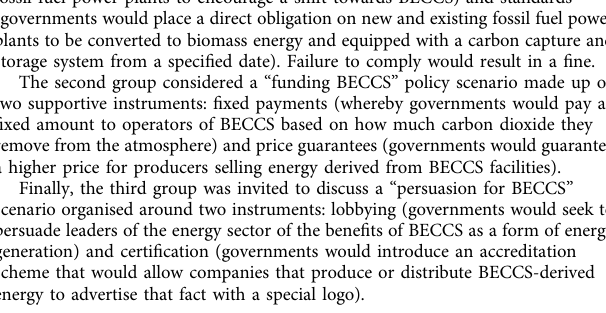
Table 4 Policy scenarios for bioenergy with carbon capture and storage Policy